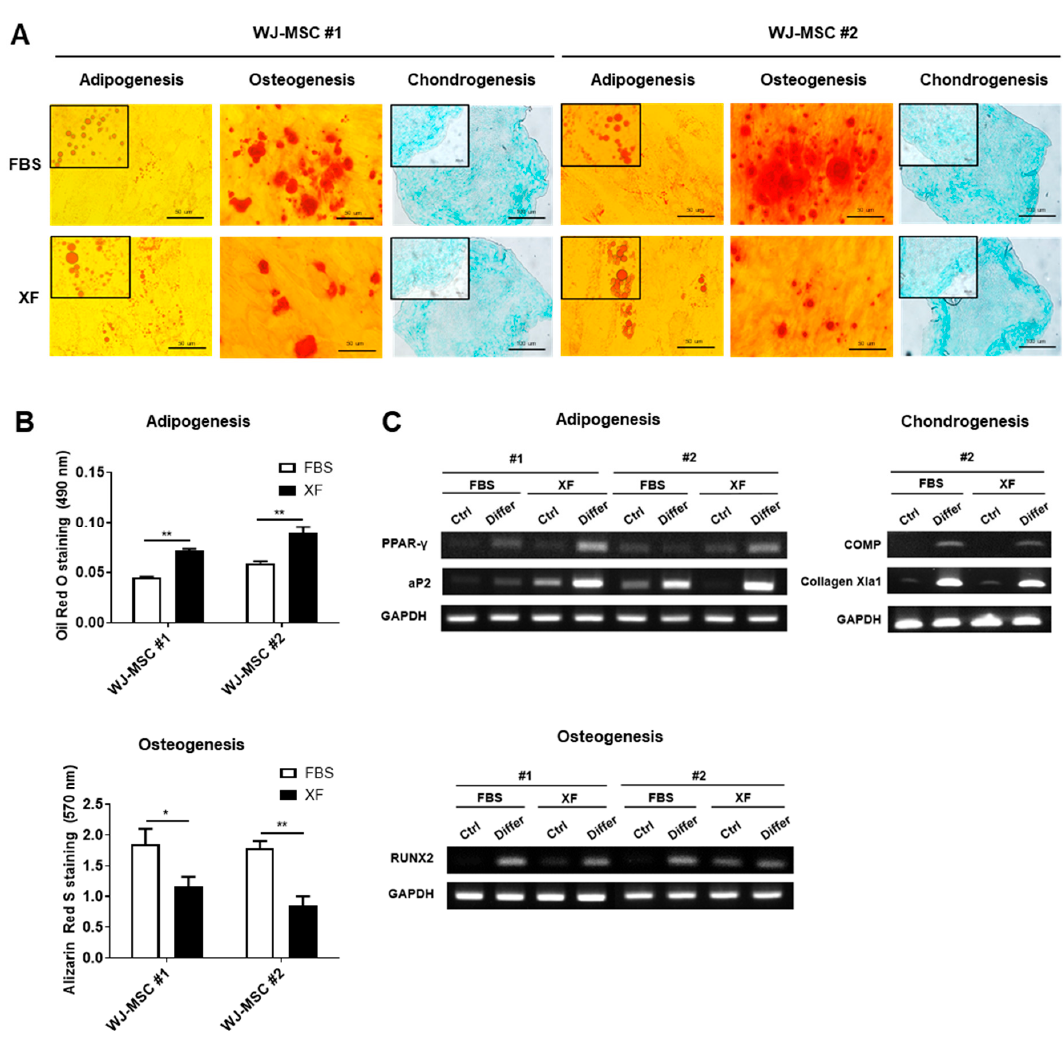
Figure 2. Di ff erentiation potential of WJ-MSCs cultured in FBS and XF conditions. WJ-MSCs cultured in FBS and XF conditions were cultured with adipogenic, osteogenic, chondrogenic di ff erentiation medium for 21 days. ( A ) Light microscopic images show representative adipocyte, osteocyte, and chondrocyte. The lipid droplets were visualized using Oil Red O staining on adipogenic cells and calcium phosphate deposits were stained with Alizarin Red S. Glycosaminoglycans of the chondrogenic di ff erentiated cells were stained with Alcian Blue. Representative images from at least three independent experiments are shown. ( B ) Quantification of the released dye of Oil Red O staining and Alizarin Red S staining were measured by a spectrophotometer. Data are represented as the means ± S.D. of triplicate experiments (* p < 0.05, ** p < 0.01). ( C ) Expressions of adipogenic (PPAR- γ , aP2), osteogenic (RUNX2), and chondrogenic (COMP, Collagen Xla1) genes were determined by RT-PCR with GAPDH as